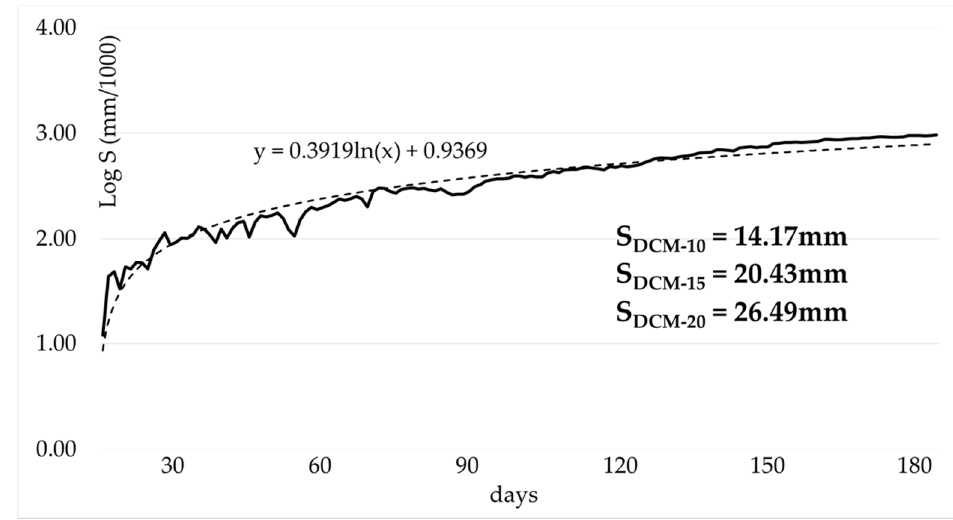
Figure 7. Long-term settlement predicted by the Log S–T curve.